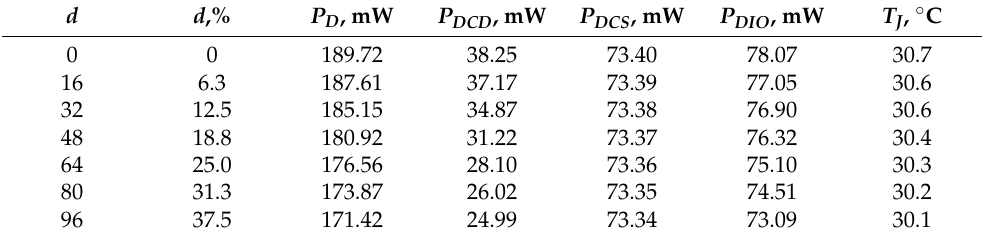
Table 2. Dissipated power and temperature of FPGA system chip when n = 64.